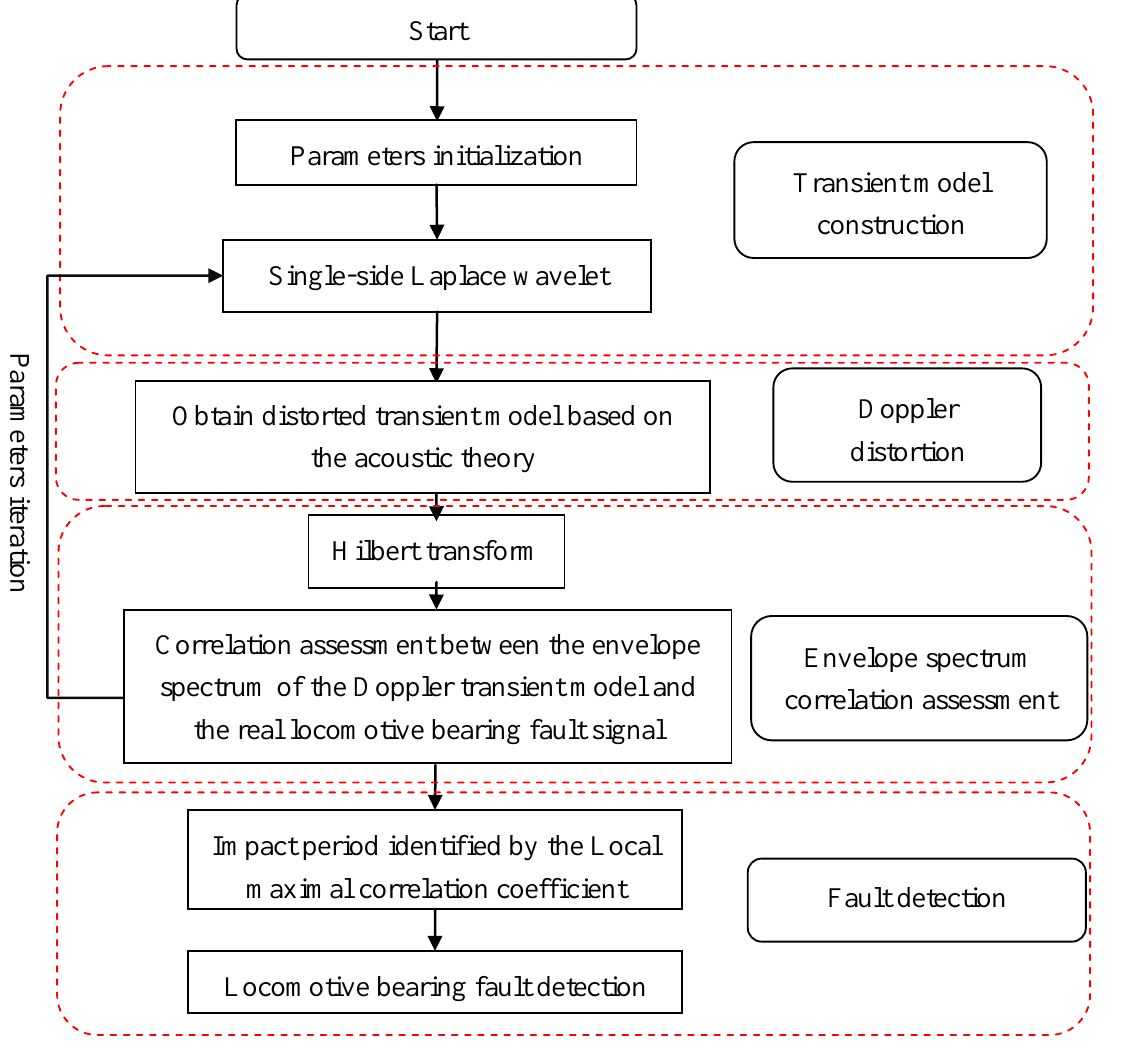
Figure 2. Flowchart of the proposed locomotive bearing fault